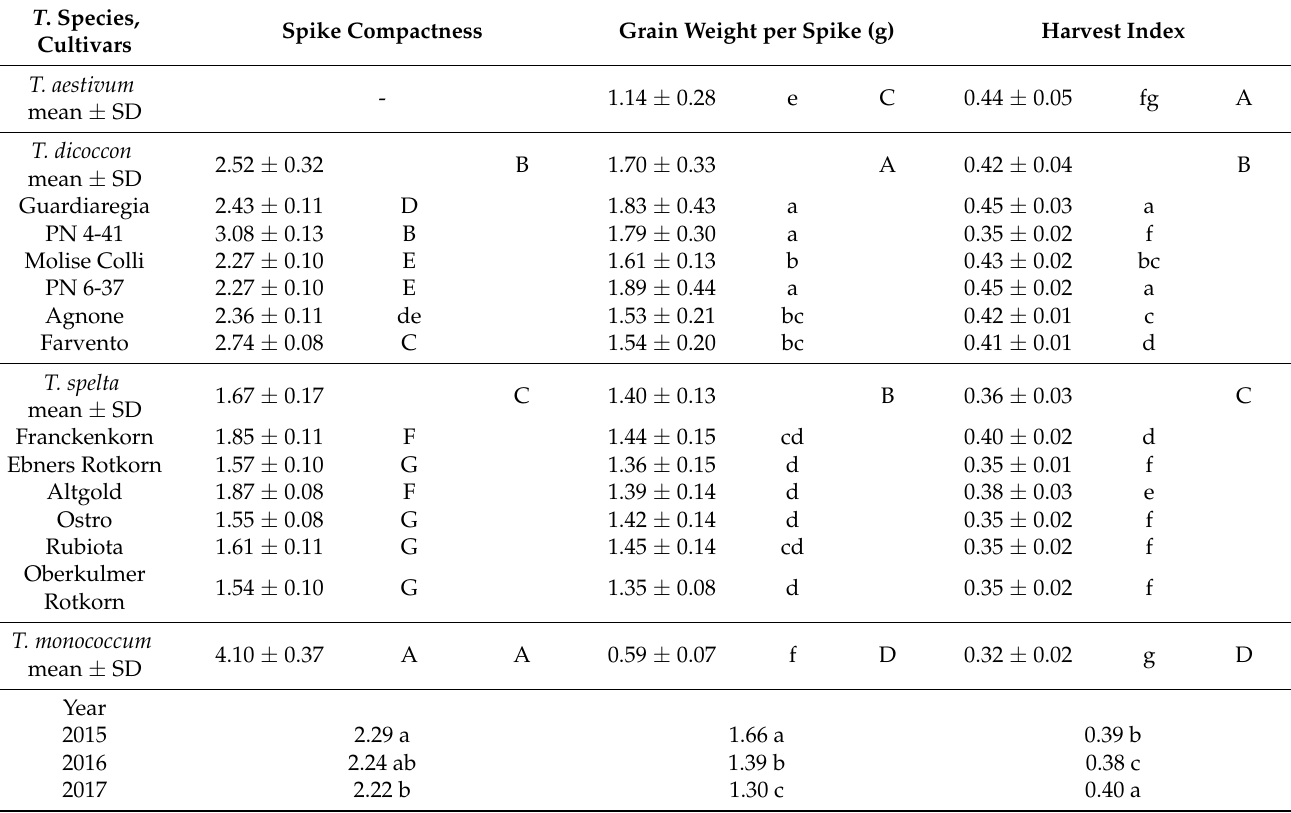
Table 2. Agro-morphological traits of wheat species and cultivars (spike traits, yield components).